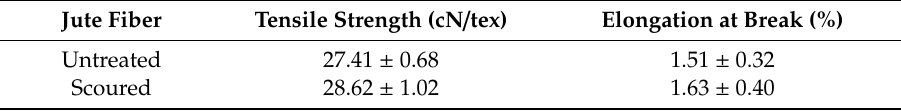
Table 2. Tensile strength and elongation at break of single jute